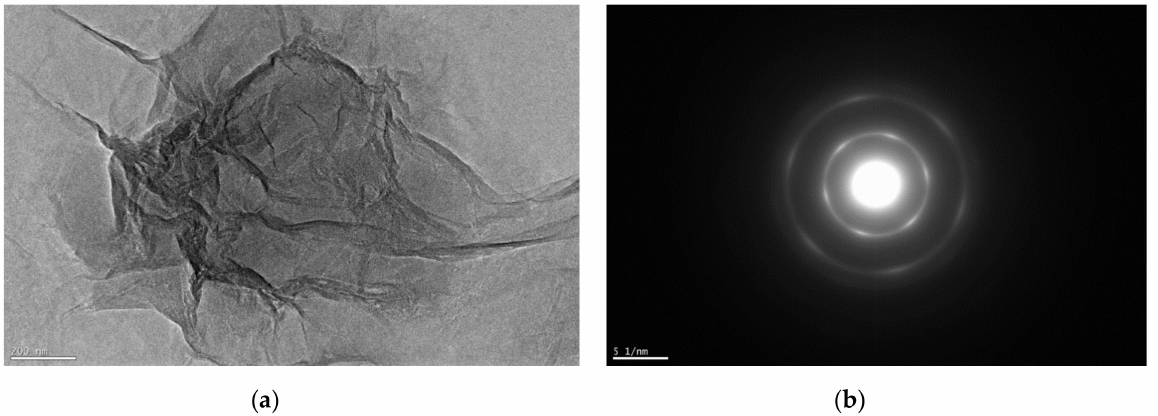
Figure 8. ( a ) TEM of HGO magnification 15 kx, ( b ) electron diffraction micrograph of HGO. Atomic force microscopy is one of the main methods for direct identification and confirmation of thickness and roughness of single and layered graphene material. GO was sonicated before detection to avoid agglomerates in the sample. Freshly AFM probe apex and SiO 2 surface were used to eliminate defects. The GO films are known to present wrinkles and overlaps. TGO and HGO consist of a few stacked layers. Topographic images of GO layers are shown in Figures 9 and 10 together with the height profiles taken along lines. Figure 9 shows an individual TGO flake, which is less than 2 µ m in diameter and based on height profile, only 2 nm thick. The thickness of the monolayer GO flake is in the area of 0.7–1 nm; accordingly, the shown flake consists of two layers [16,17]. However, discrepancies in values for single-layer graphene measured by various modes of AFM are in the range of 0.3 to 1.7 nm [47]. Figure 10 shows an HGO flake of 4 µ m in diameter which is approximately 3 nm thick and corresponds to three GO layers. HGO has a significantly rougher and wrinkled surface than